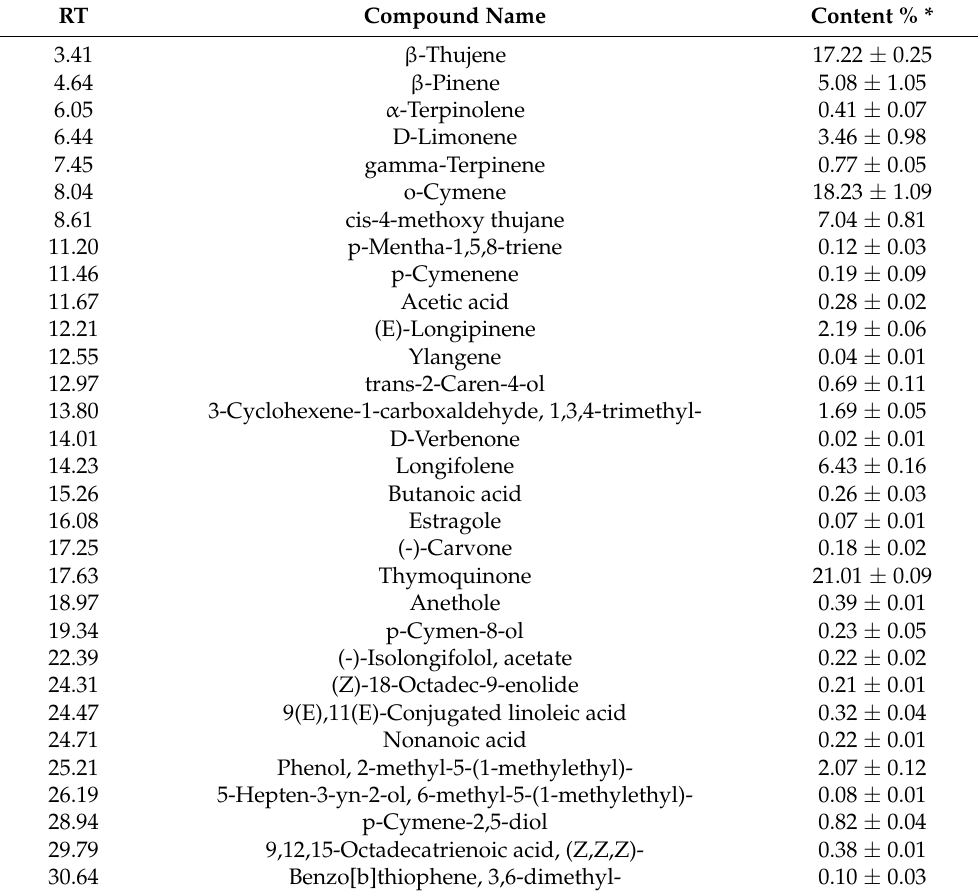
Table 3. GC–MS analysis of volatile compounds, retention time (RT) and their amounts detected in the extract of black